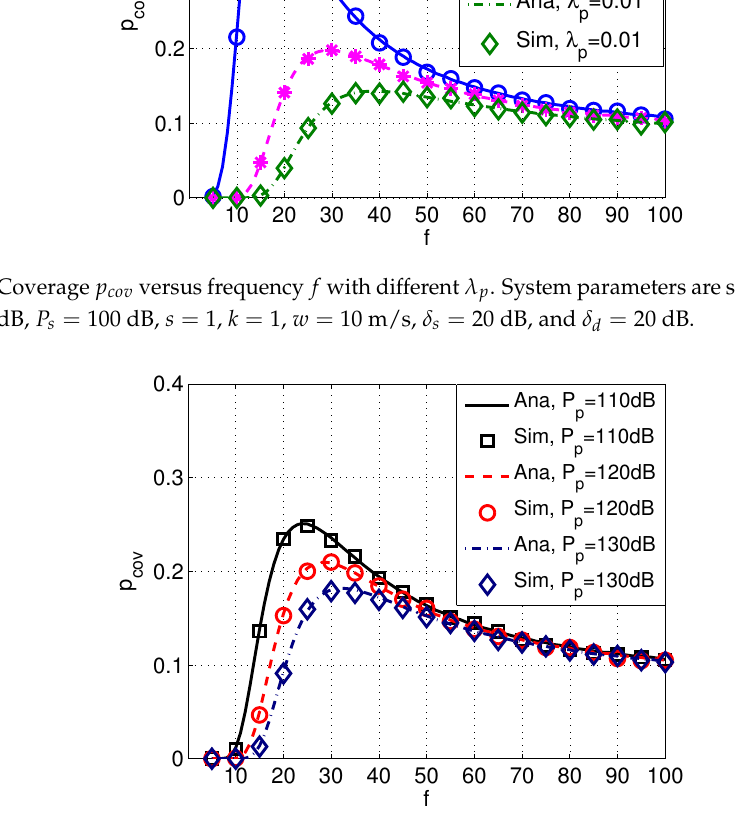
Figure 10. Coverage p cov versus frequency f with different power of PUs P p . System parameters are set as R d = 12 km, P s = 100 dB, λ p = 0.003, k = 1, w = 10 m/s, s = 1, δ s = 20 dB, and δ d = 20